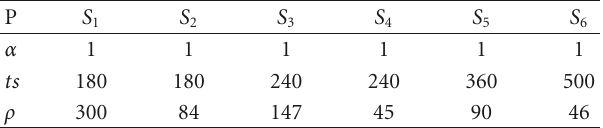
Table 3: Tra ffi c figures for balanced tra ffi c experiments.